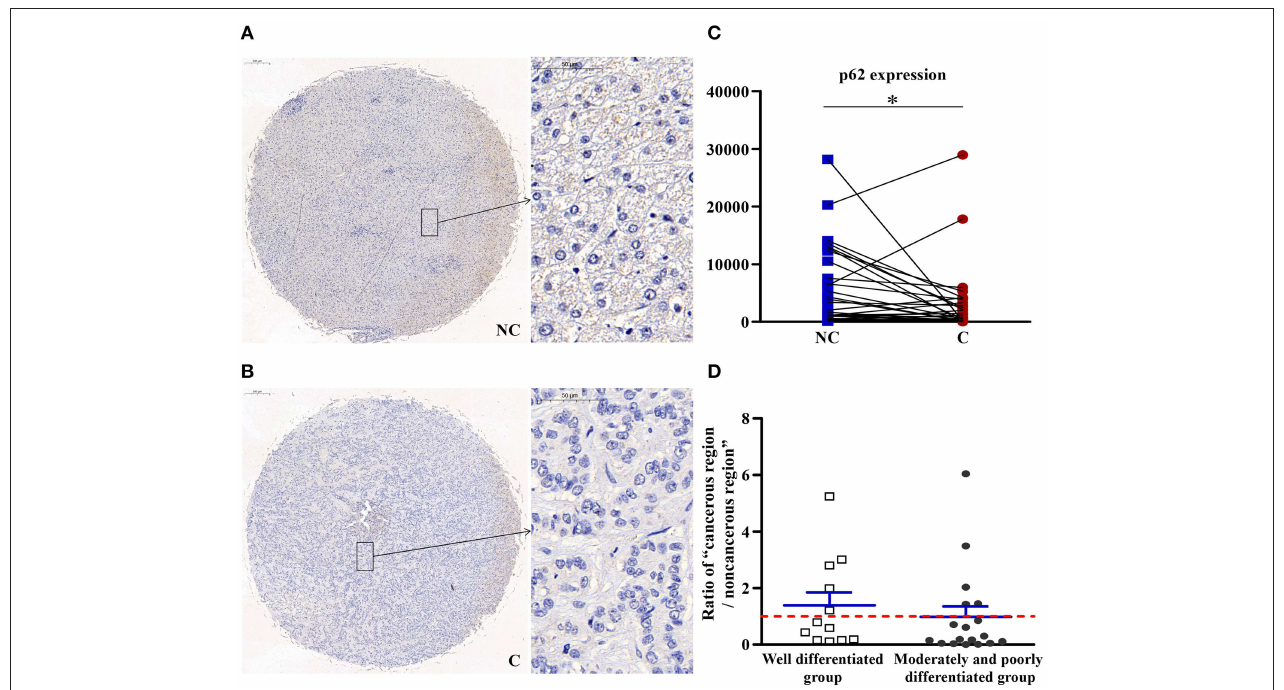
FIGURE 8 | The detailed expression of p62. Representative images of p62 protein expression in liver cancer’s corresponding (A) non-cancerous (NC) and (B) cancerous (C) regions. (C) Quantification of p62 expression level using multispectral image analysis in the liver cancer samples. (D) The ratio of “cancerous region/non-cancerous region” of p62 expression in two groups (well-differentiated group vs. moderately and poorly differentiated group). The red line indicates that the ratio is equal to 1. Scale bar: 200 or 50 µ m. *Denotes significant differences from the noncancerous region with P <